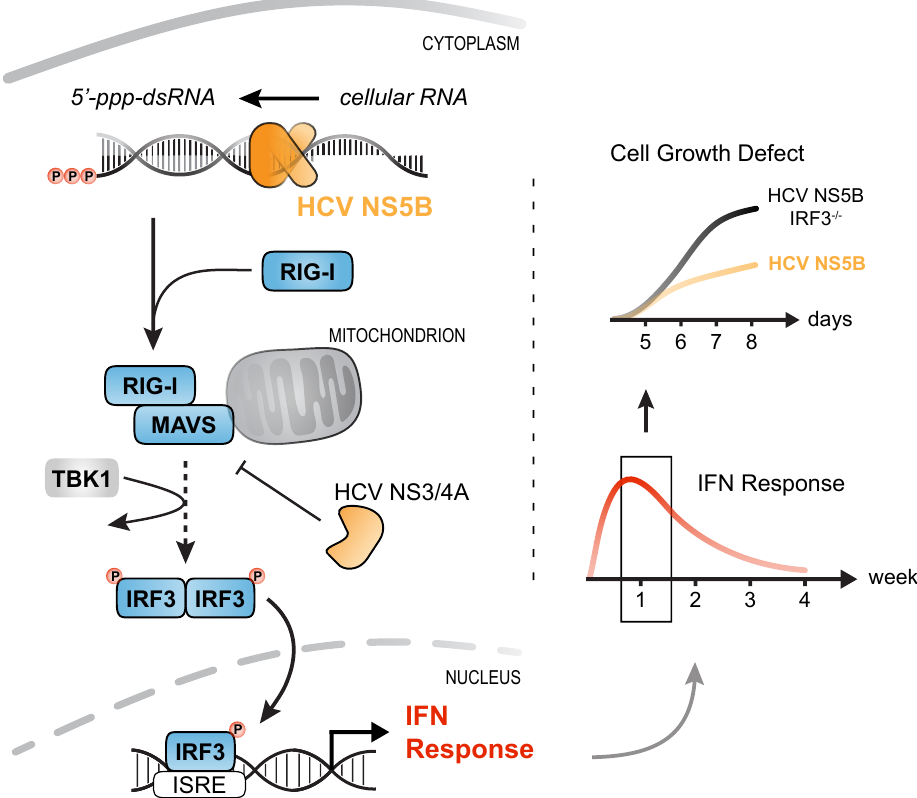
Figure 7. IRF3-mediated, but interferon- and caspase-independent cytostasis upon prolonged activation of RLR signaling. Expression of HCV NS5B generates virus-like immune-stimulatory dsRNAs from cellular RNA that are detected by the pattern-recognition receptor RIG-I. Activation of RIG-I triggers downstream signaling via MAVS, IRF3 phosphorylation, and subsequent translocation into the nucleus. IRF3 binding to the IFN- β and - λ promotor enhancers induces expression of IFNs which activate the antiviral immune system. Prolonged stimulation of the innate immune response caused a prominent IRF3-mediated growth defect of cells most strongly stimulated and was independent of IFN signaling or caspase activity. By targeting MAVS through NS3 / 4A, HCV not only dampens activation of the IFN response, but also restores cell viability in infected